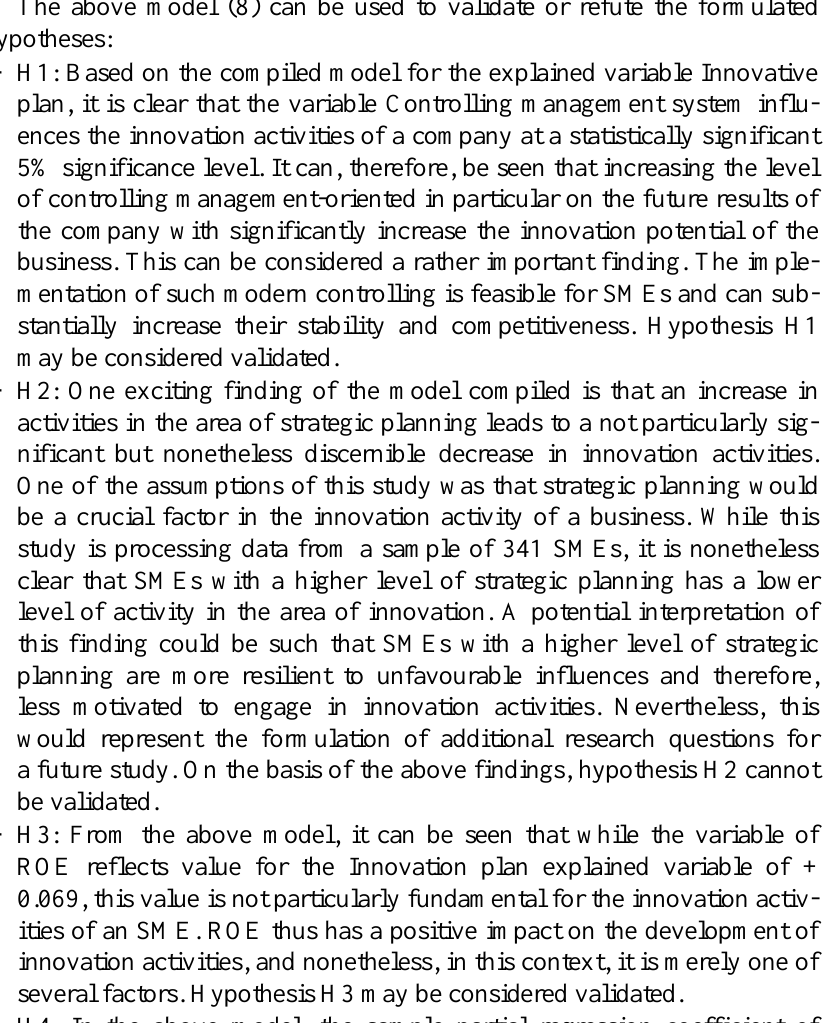
Table 4 indicates how the value of the multiple coefficients of determi- nation (R-squared) grows with the gradual inclusion of variables in the model. A strong dependence can subsequently be seen from the